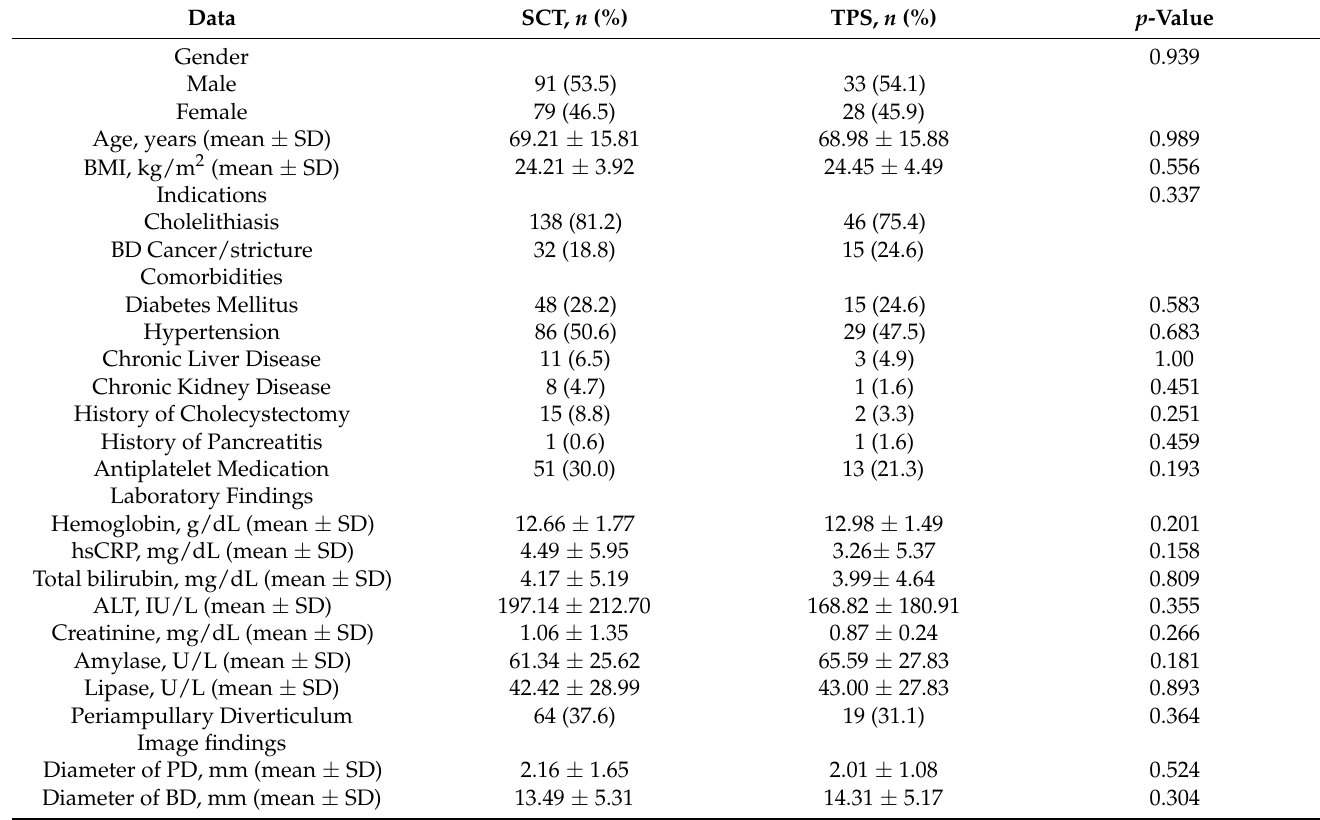
Table 1. Clinical characteristics of patients undergoing